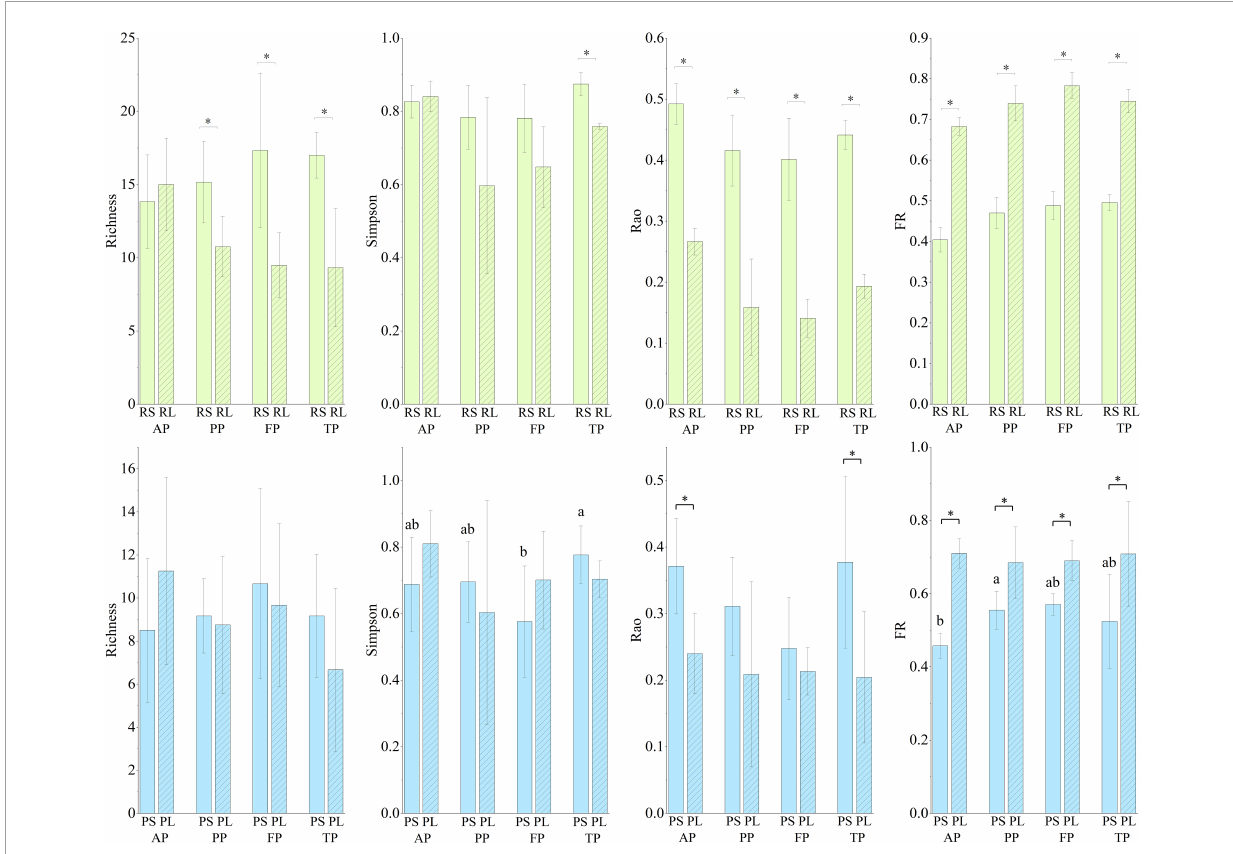
FIGURE7 Richness, Simpson’s, Rao’s, and functional redundancy (FR) in the four types of substrates during the four periods. Light black asterisk indicated significant difference between the riffle stones and the riffle litters ( p < 0.05); dark black asterisk indicated significant difference between the pool sediments and the pool litters ( p < 0.05); different small letters represent significant difference in Simpson’s diversity and functional redundancy among periods in the pool sediments ( p < 0.05). RS, riffle stones; PS, pool sediments; RL, riffle litters; PL, pool litters; AP, the autumn period; PP, the pre-freezing period; FP, the freezing period; TP, the thawing period.